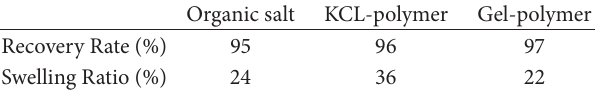
Table 5: Swelling ratio and recovery of the Nahr Umr Shale.